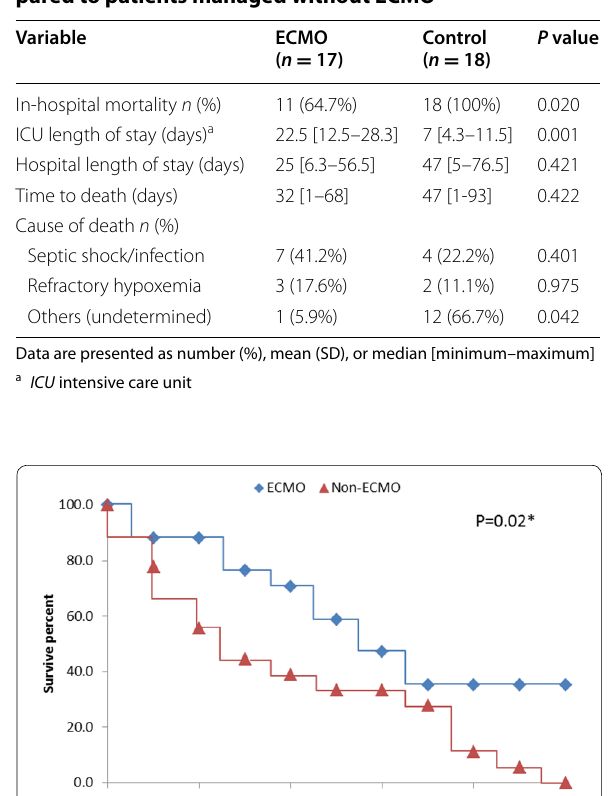
Table 5 Outcomes of patients treated with ECMO com- pared to patients managed without ECMO